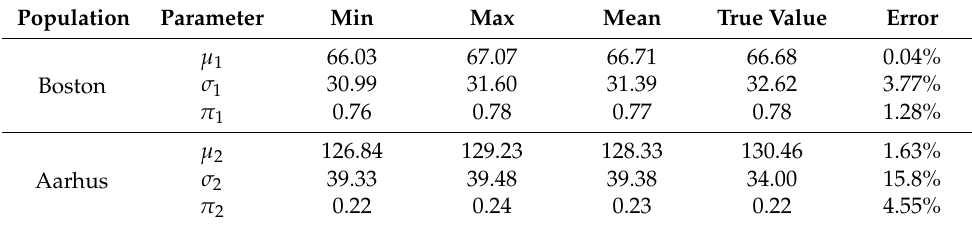
Table 1. Summary of the parameter estimation for fixed variance.